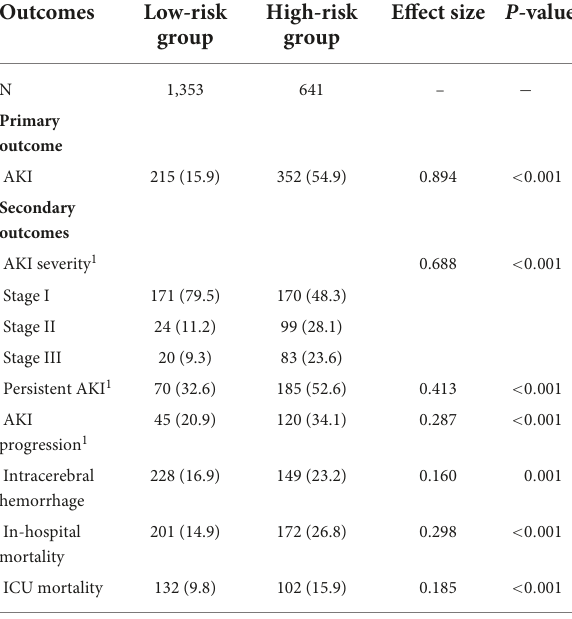
TABLE 4 Clinical outcomes analysis of high- and low-risk groups for all patients.